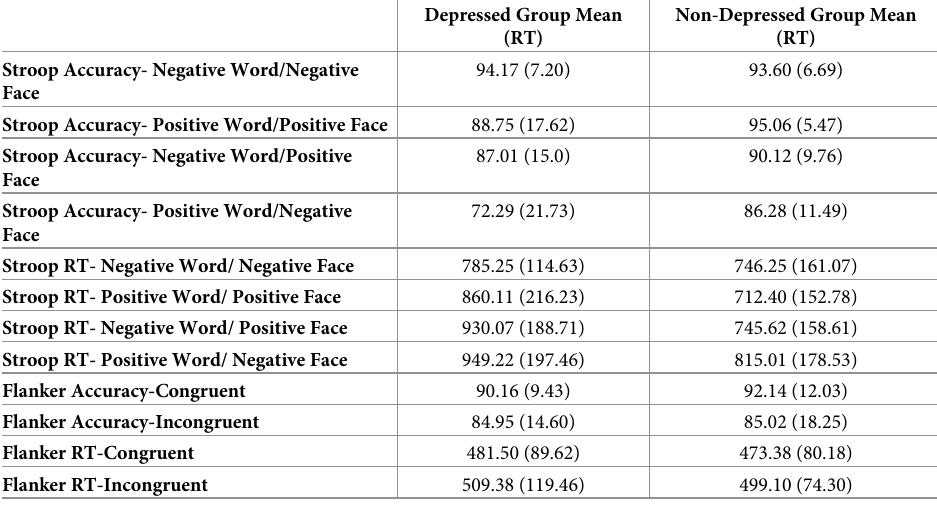
Table 3. Group differences in the Stroop and Flanker